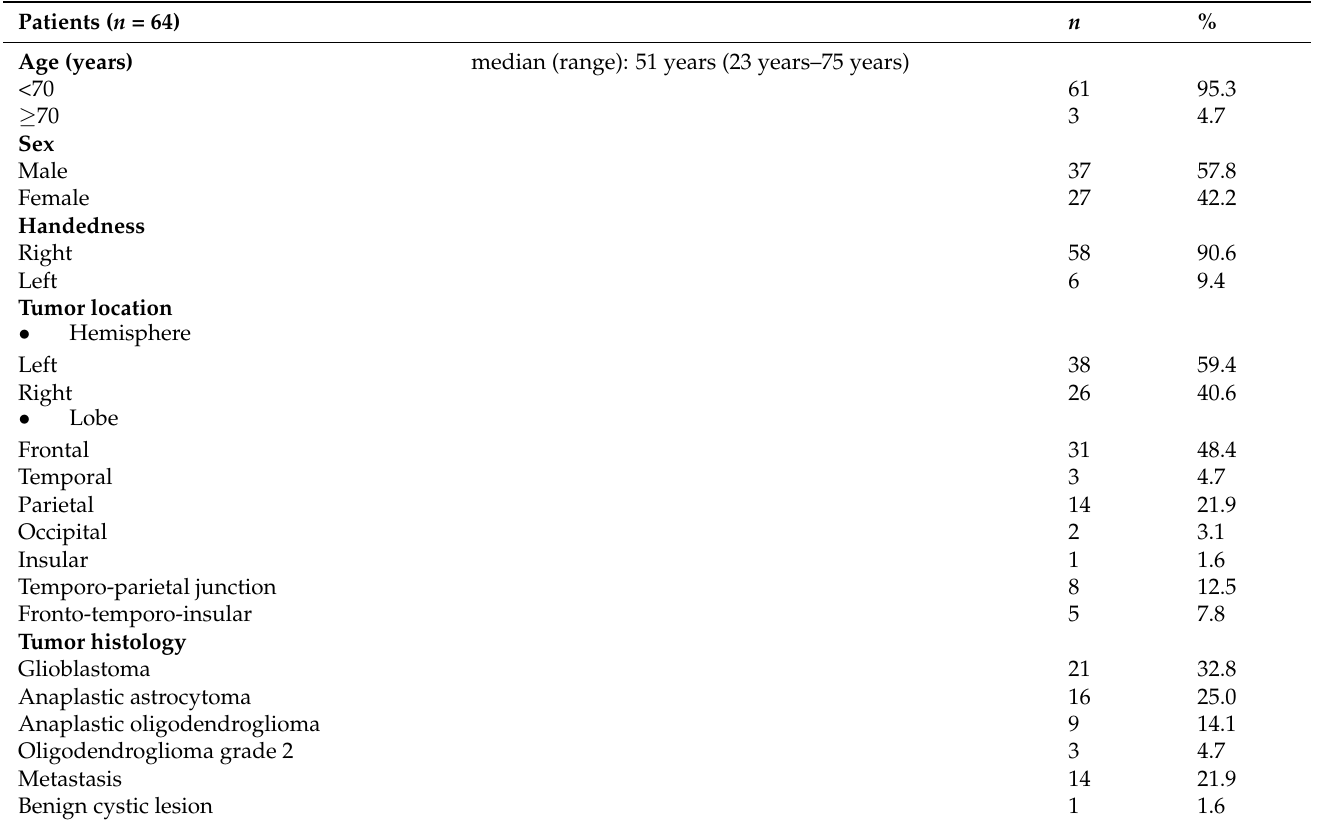
Table 1. Characteristics of the 64 patients and the 69 AC procedures (AC, awake